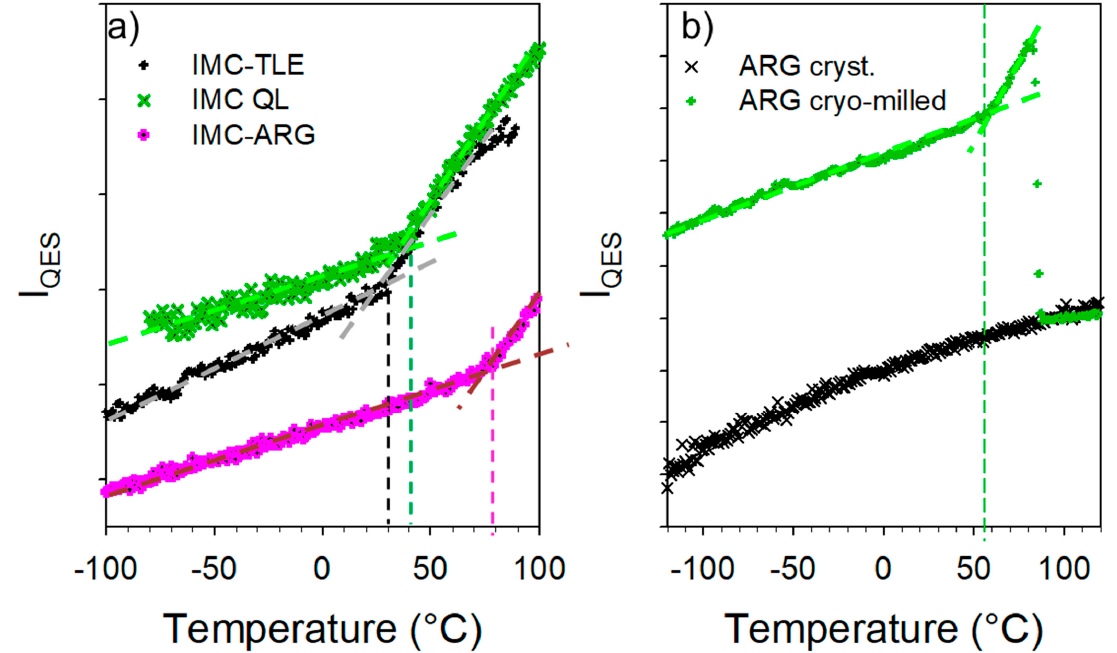
Figure 8. Temperature dependence of the quasielastic intensity ( a ) determined for IMC–TLE and IMC–ARG blends compared with that of the glassy state of the IMC and ( b ) determined in the amorphous ARG compared with that of the crystalline ARG.